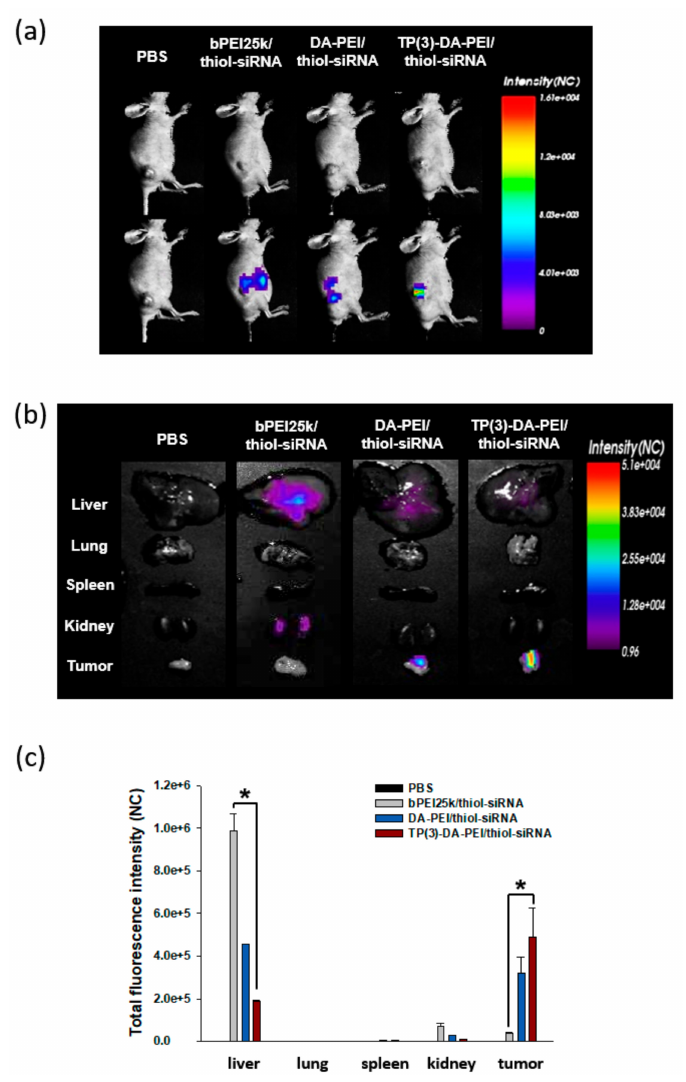
Figure 7. ( a ) In vivo imaging in A549 tumor of subcutaneous model-bearing nude mice at 12 h after intravenous injection of PBS, bPEI25k/Cy5.5-thiol-siRNA, DA-PEI/Cy5.5-thiol-siRNA, and TP(3)-DA-PEI/Cy5.5-thiol-siRNA polyplexes. ( b ) Representative images of dissected organs and tumors at 12 h after intravenous injection of these four polyplexes. ( c ) Corresponding total fluorescence intensity of organs and tumors. The results are presented as means ± SD and analyzed using Student’s t -test ( n = 3, * p <